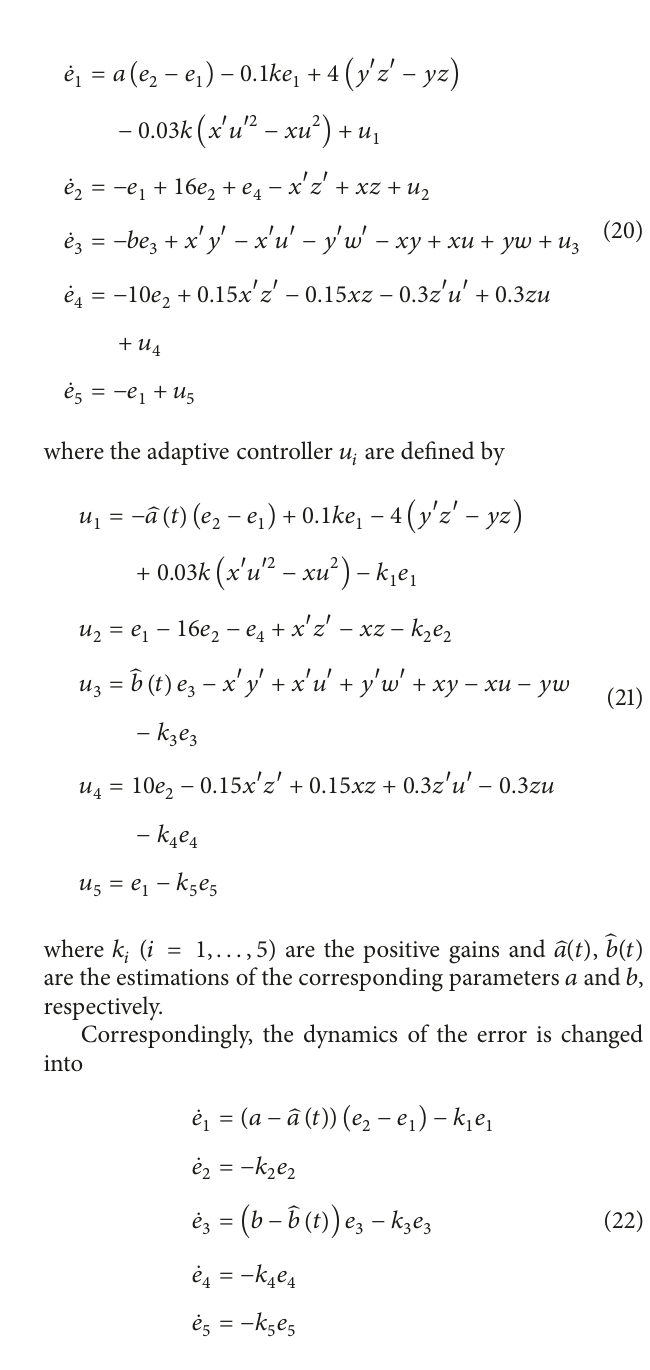
Figure 3: 𝑊(𝑢) function-memristor channel.